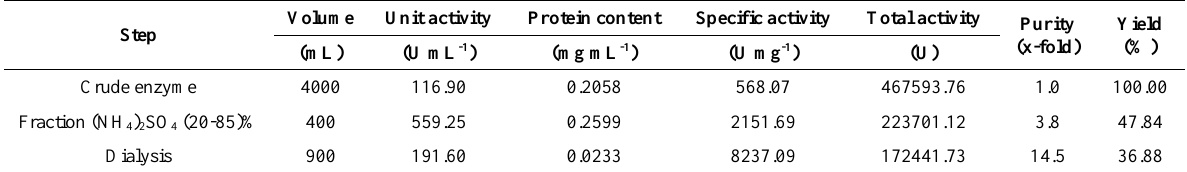
Table 1. Partial purification procedures summary of A. fumigatus